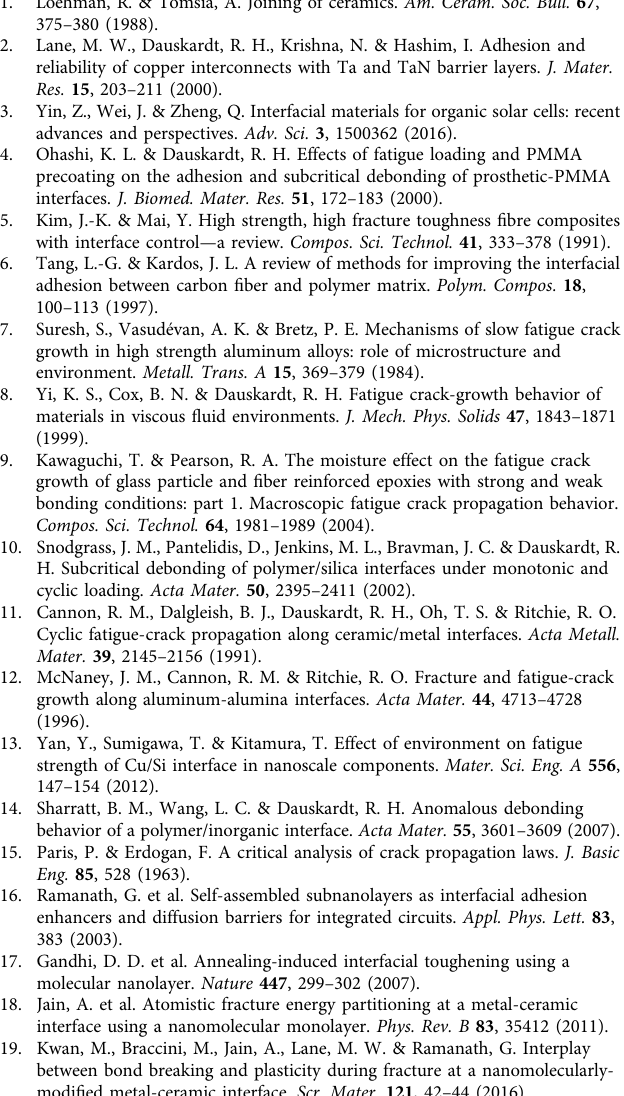
plasticity and crosslinking of healing agents released during microvoid growth in the polymers.